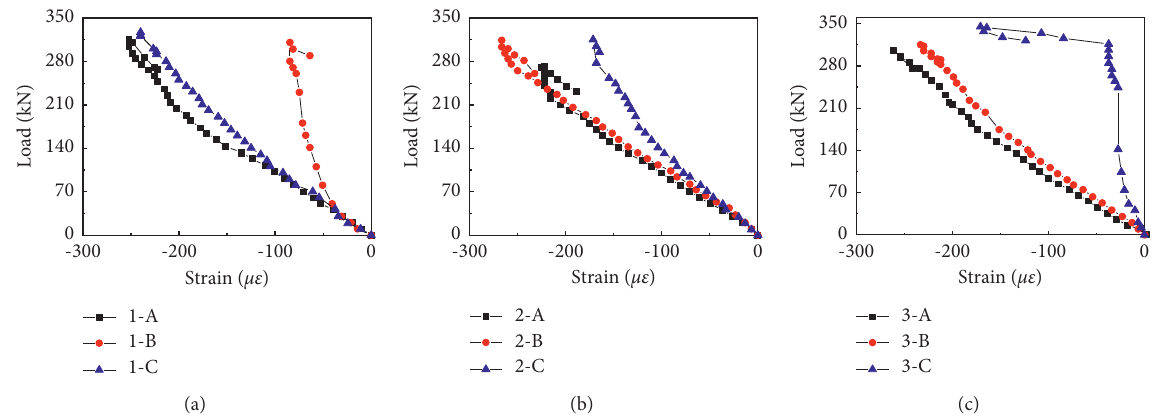
Figure 17: Load-strain curves of No. 37 measuring point. (a) First group. (b) Second group. (c) Third group.